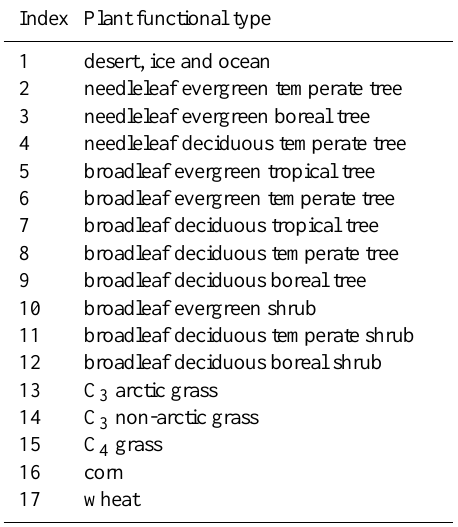
Table 1. Plant functional types in land model of the